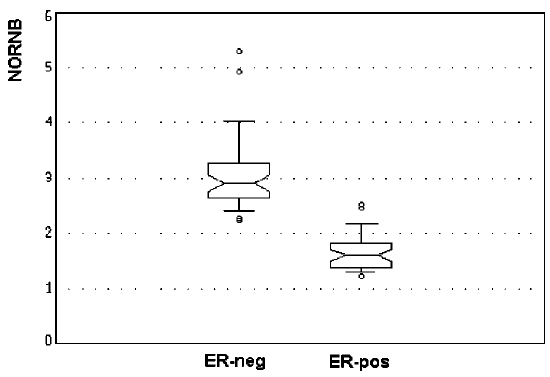
Fig. 1. Mean AgNOR number per nucleus (NORNB) in ER-negative (ER-neg) and ER-positive (ER-pos) tumor cell nuclei.